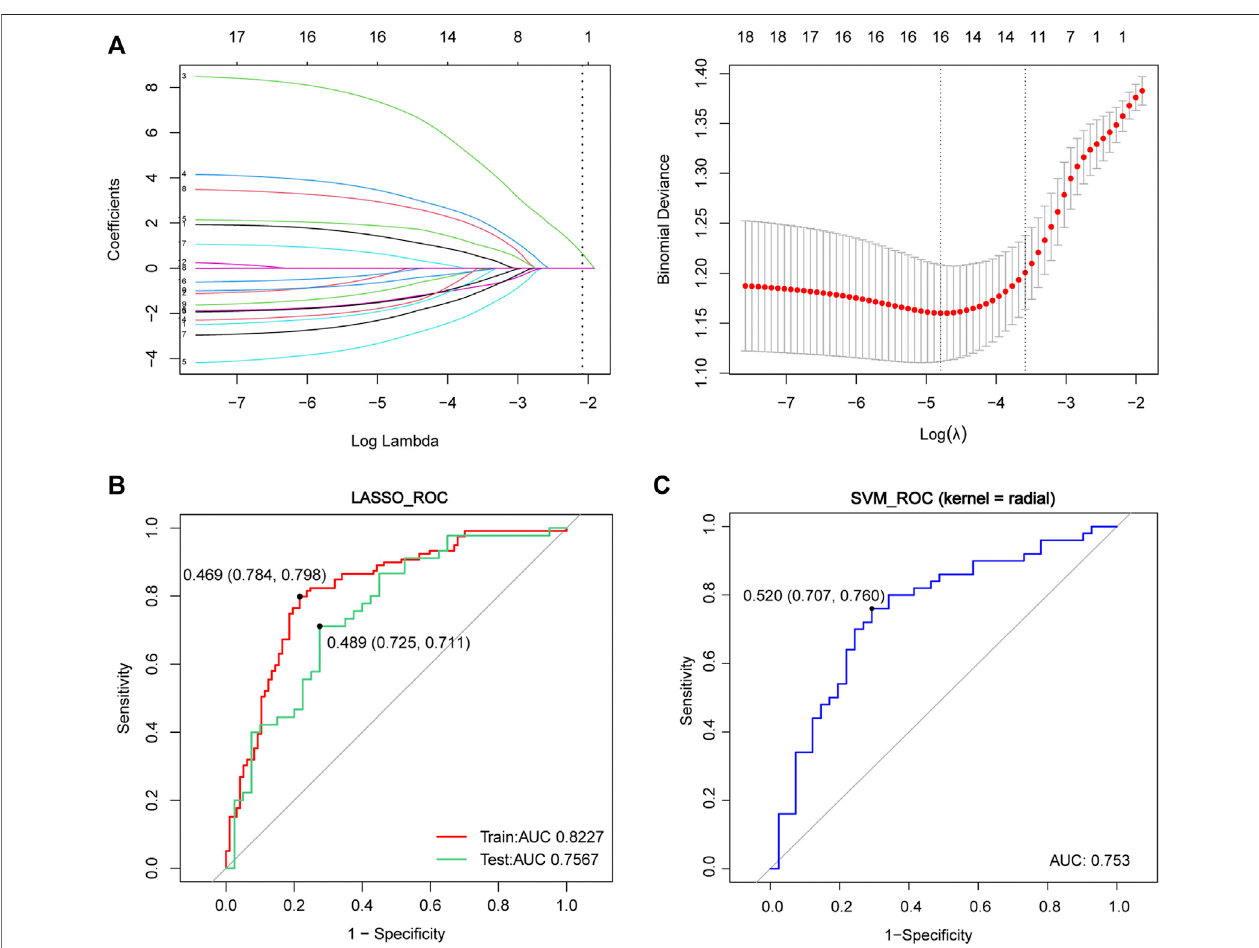
FIGURE 7 | Construction of the LASSO and SVM model in the whole blood data. (A) Construction of the LASSO model. (B) ROC curve in the blood dataset of training data (red lines, N = 216, AUC = 0.8227), testing data (green lines, N = 85, AUC = 0.7567) and in the SVM model (blue lines, N = 301, AUC = 0.753) (C) Red and green lines represent the ROC of training and test data in the LASSO model, respectively, where the blue line represents the ROC in the SVM model. Abbreviations: LASSO, least absolute shrinkage and selection operator; ROC, receiver of characteristic curve; AUC, area under curve; SVM, support vector machine.